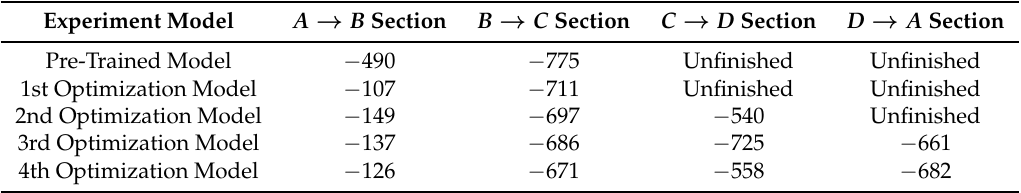
Table 3. Cumulative rewards on each